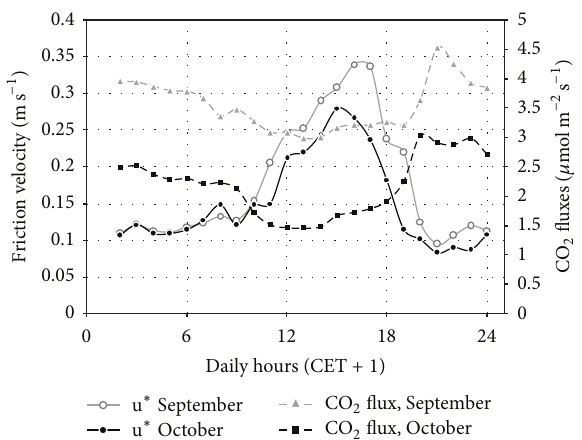
Figure 8: Atmospheric turbulence (mean daily pattern) and CO 2 fluxes in the postharvest period (September-October) at the NT site. (NT = no-tillage